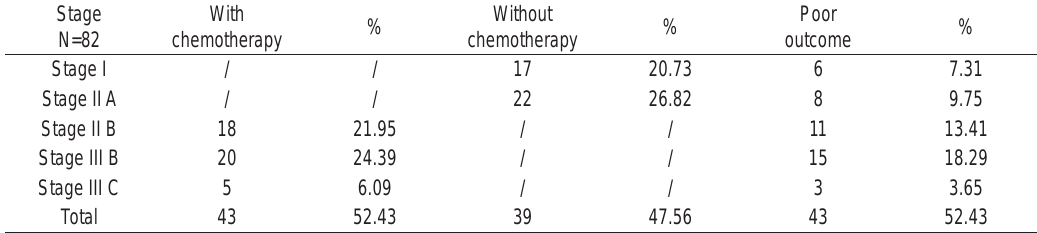
TABLE 3. Patients with different stage of the disease who received chemotherapy and the outcome of the disease Stage N=82